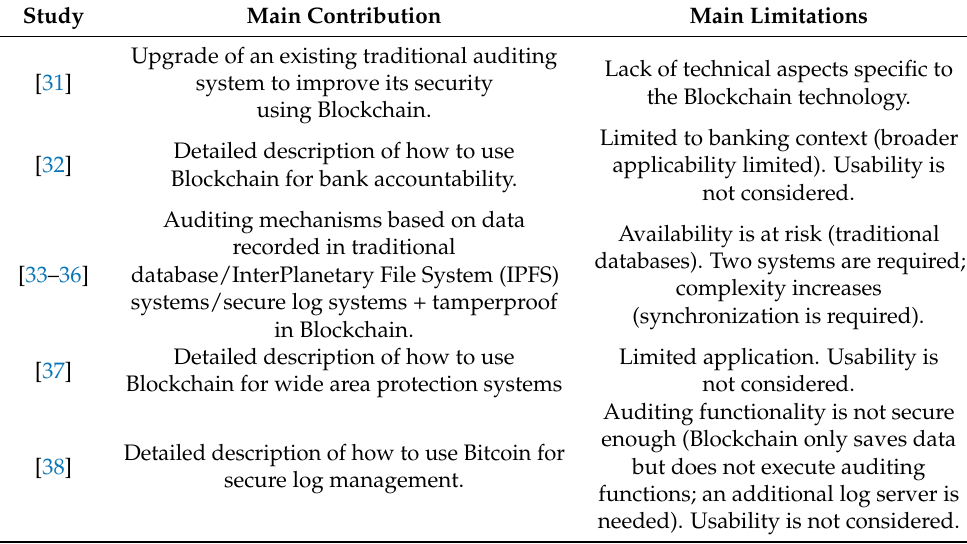
Table 1. Blockchain-based audit trail existing approaches (contributions and